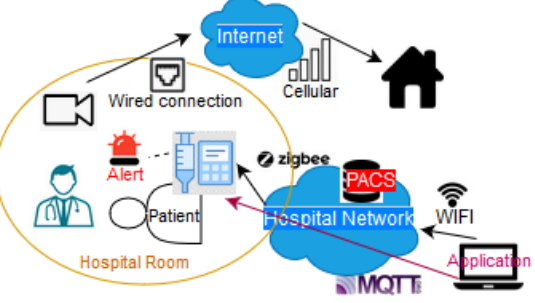
Figure 5. Typical communication protocols utilised for a remote treatment device (insulin